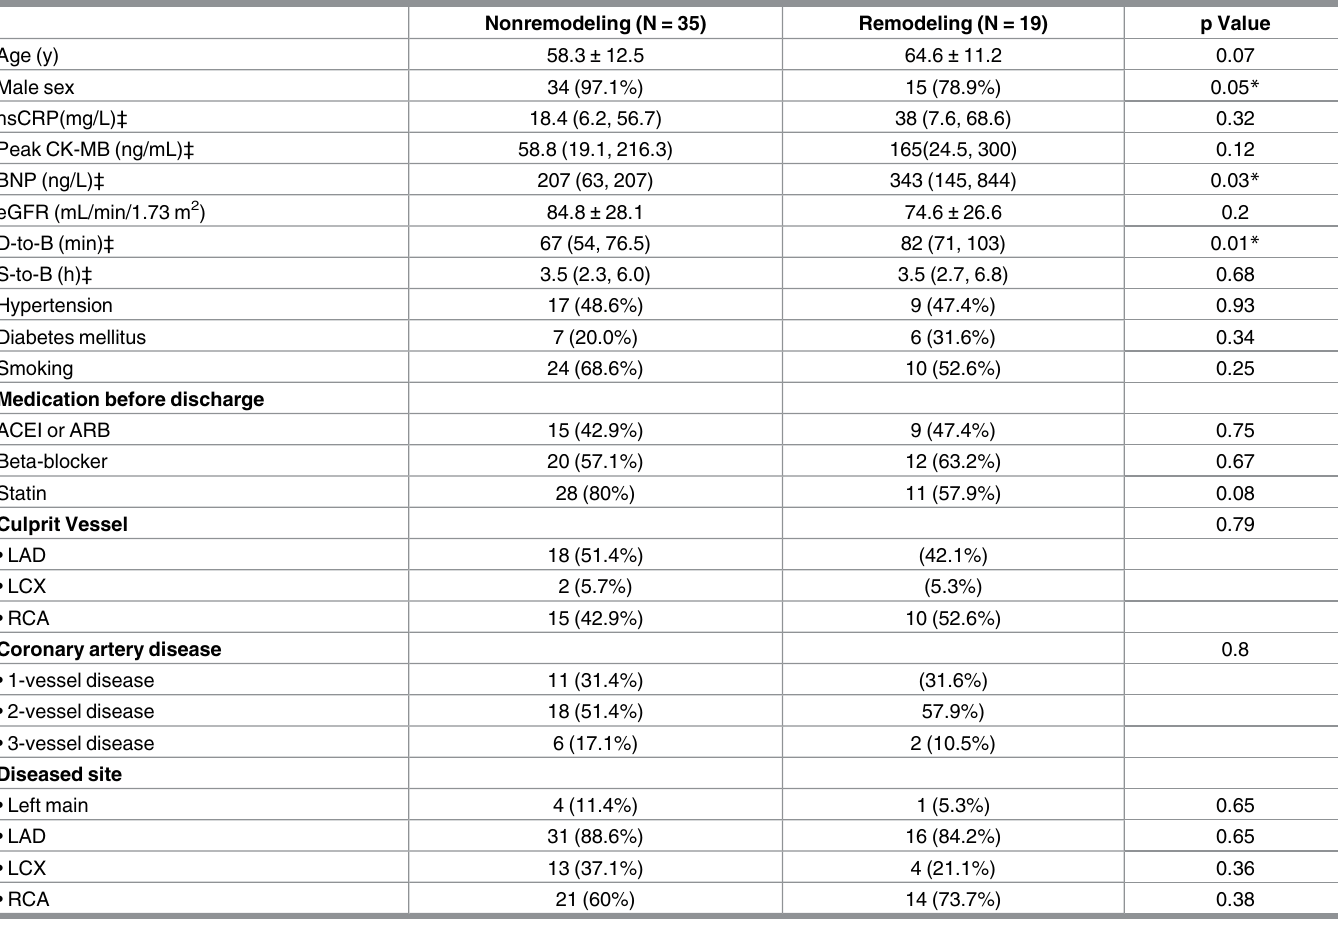
Table 5. Clinical data for STEMI